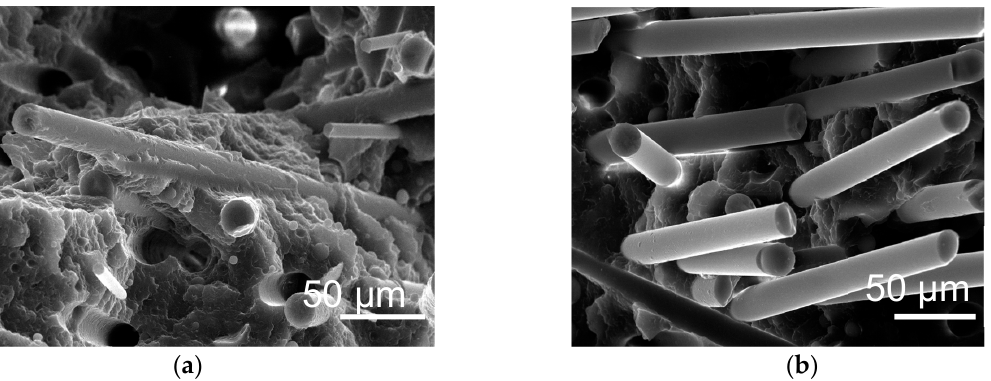
Figure 10. Comparison of wet-out with ( a ) 66% recycled and ( b ) 100% recycled content material. The 100 wt% recycle content has more dry fibers and hence lower strength and mod- ulus compared with a higher wet-out and fiber-matrix interface interaction in the 66 wt% material.